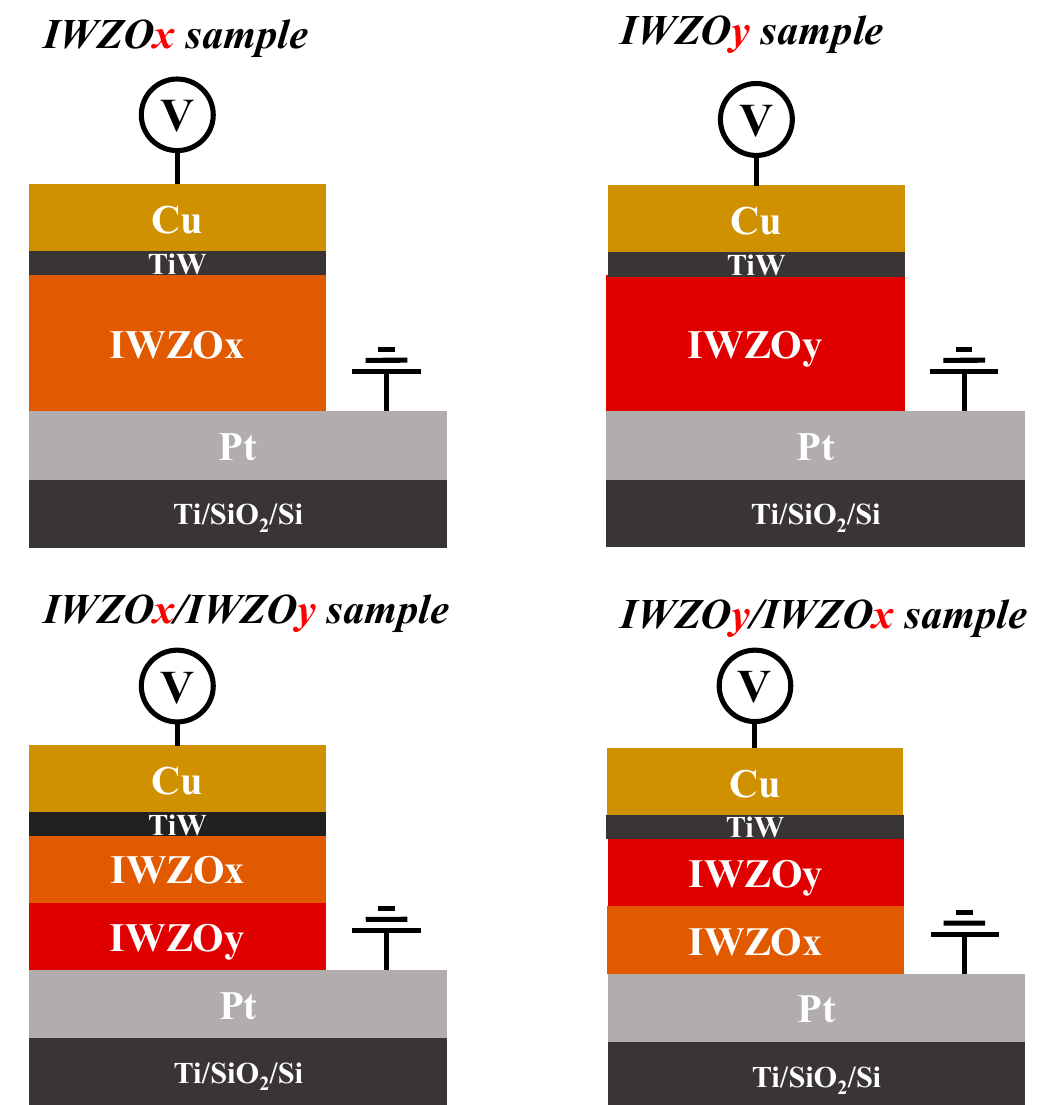
Figure 1. Schematic cross-section diagram of all CBRAM devices with different switching layers.